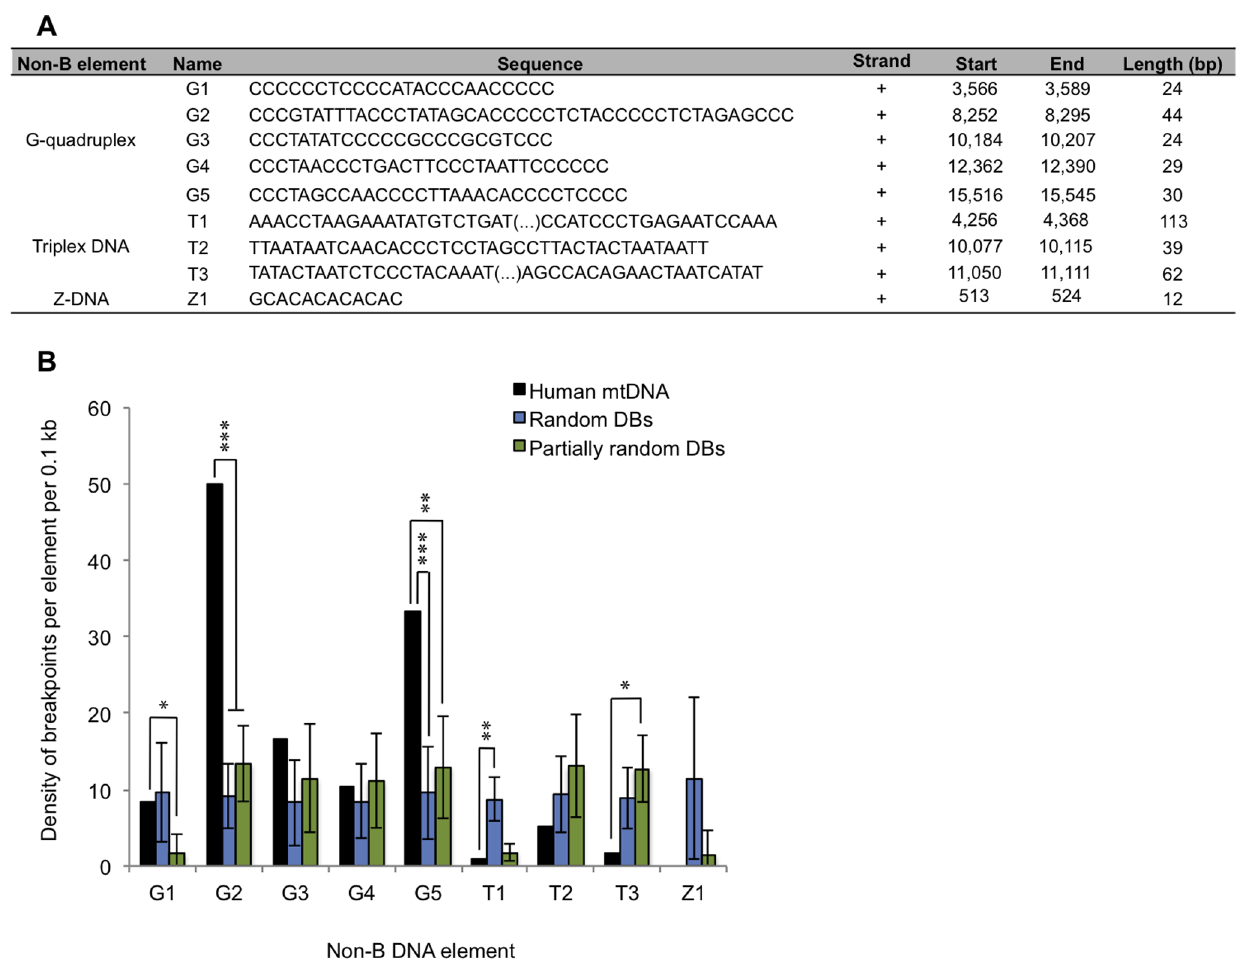
Figure 3. Impact of the presence of non-canonical (non-B) DNA structures on the distribution of deletion breakpoints. (A) Sequences and locations of the DNA strings predicted to fold into G-quadruplexes, triplexes and Z-DNA. (B) Density of deletion breakpoints per 0.1 kb bins of each non-B element (black bars). Also shown are the density values computed after randomization of breakpoint positions (shown in blue) or after partially randomization of breakpoint positions (shown in green). Error bars represent standard deviations. * p , 0.05; ** p , 0.01; *** p , 0.001.